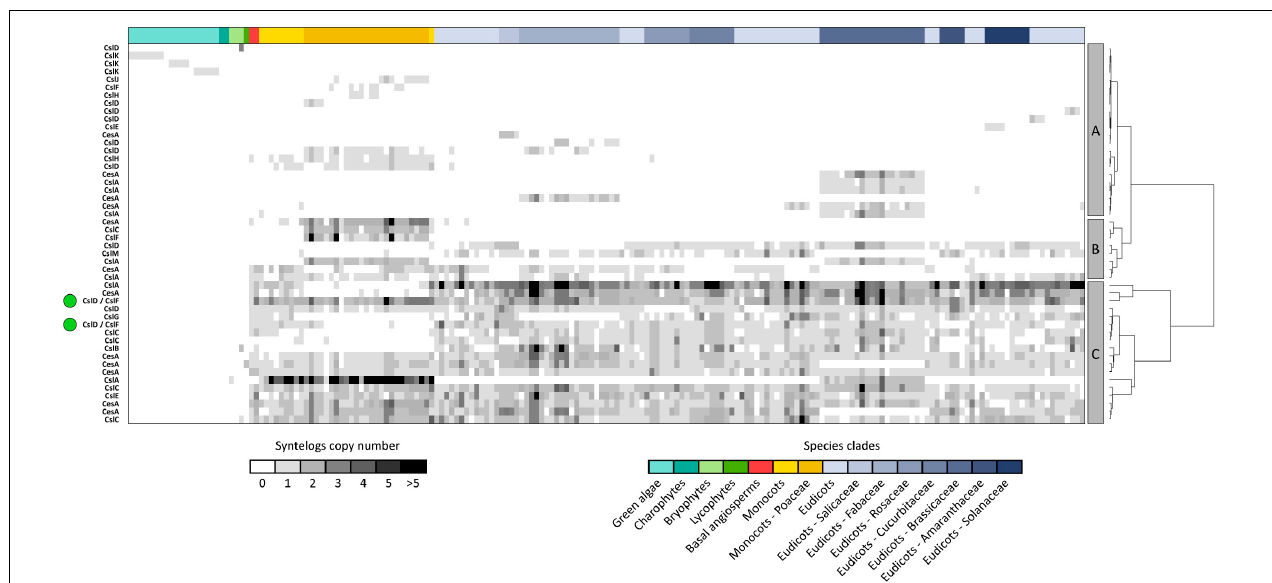
FIGURE 2 | The 48 syntenic communities detected within the CesA/Csl synteny network. Syntenic communities are groups of genes displaying higher degrees of synteny with each other than with the rest of the network. Therefore, they constitute conserved architectural configurations of genes across genomes of different species. The figure highlights that CesA/Csl communities typically harbour genes belonging to the same CesA/Csl family, except for two communities grouping CslF and CslD genes (green dots on the left of the figure). CesA/Csl syntenic communities are also divided into three main clusters based on the spread of their genes across the plant kingdom ( A–C panels and dendrogram at the right of the figure). In the figure, rows represent communities while columns represent species. Cells are coloured according to the number of syntenic genes harboured by each community and each species within communities. Row headers on the left side indicate the predominant gene family harboured by each community ( > 90% of the community